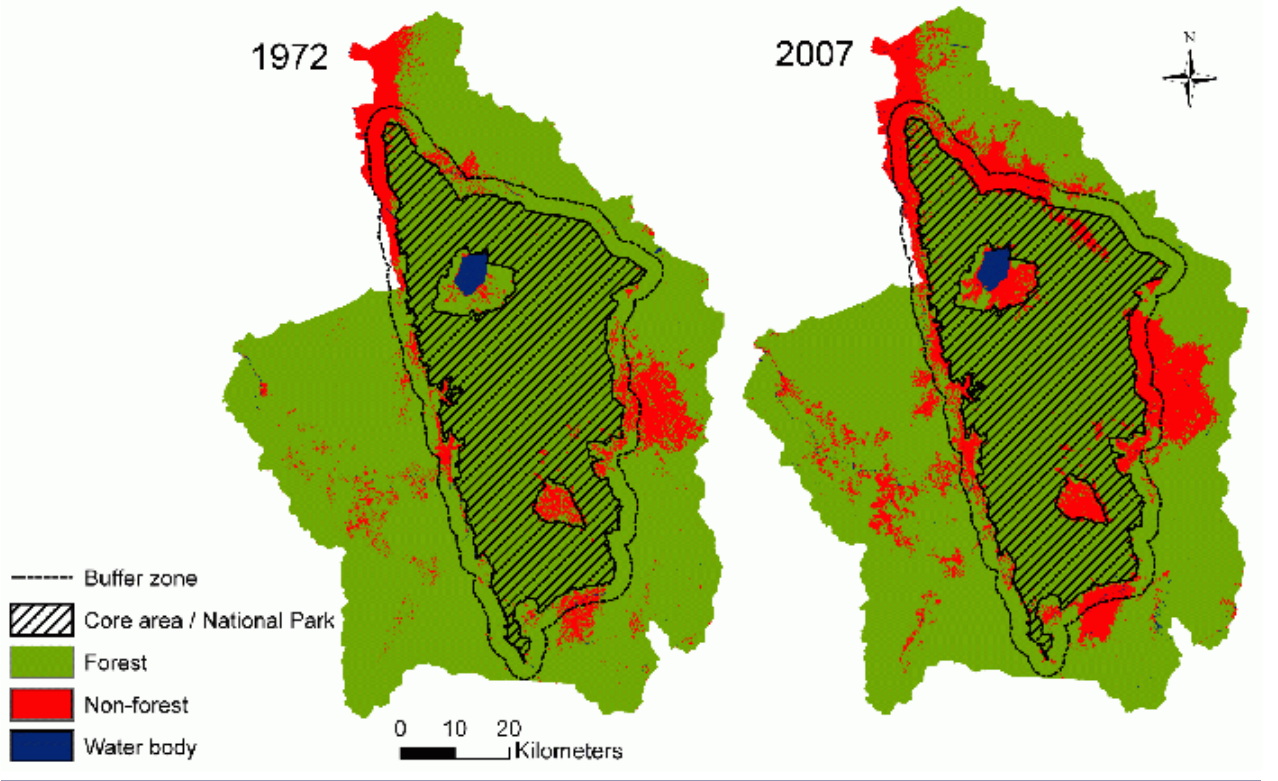
Fig. 2 . Area of forest and non-forest cover in Lore Lindu Biosphere Reserve in 1972 and 2007. Data source: Stability of Rainforest Margins Project (STORMA), University of Göttingen, Germany; own